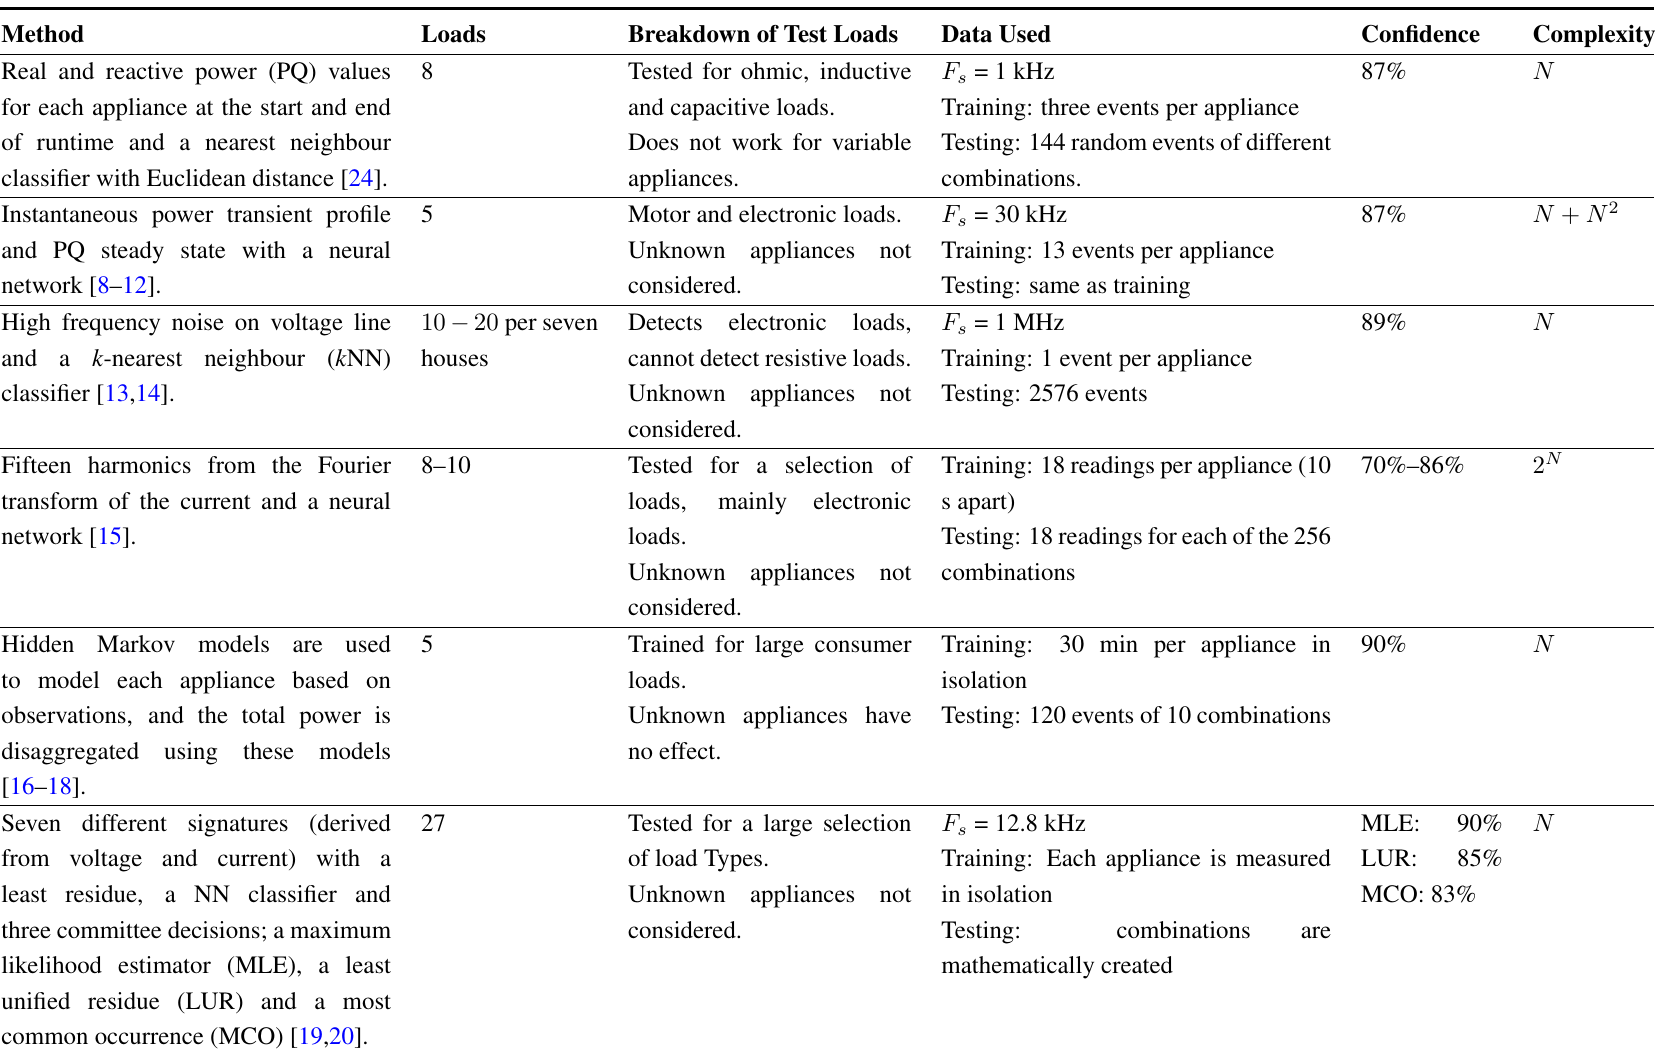
Table 1. Comparison of complete load monitoring